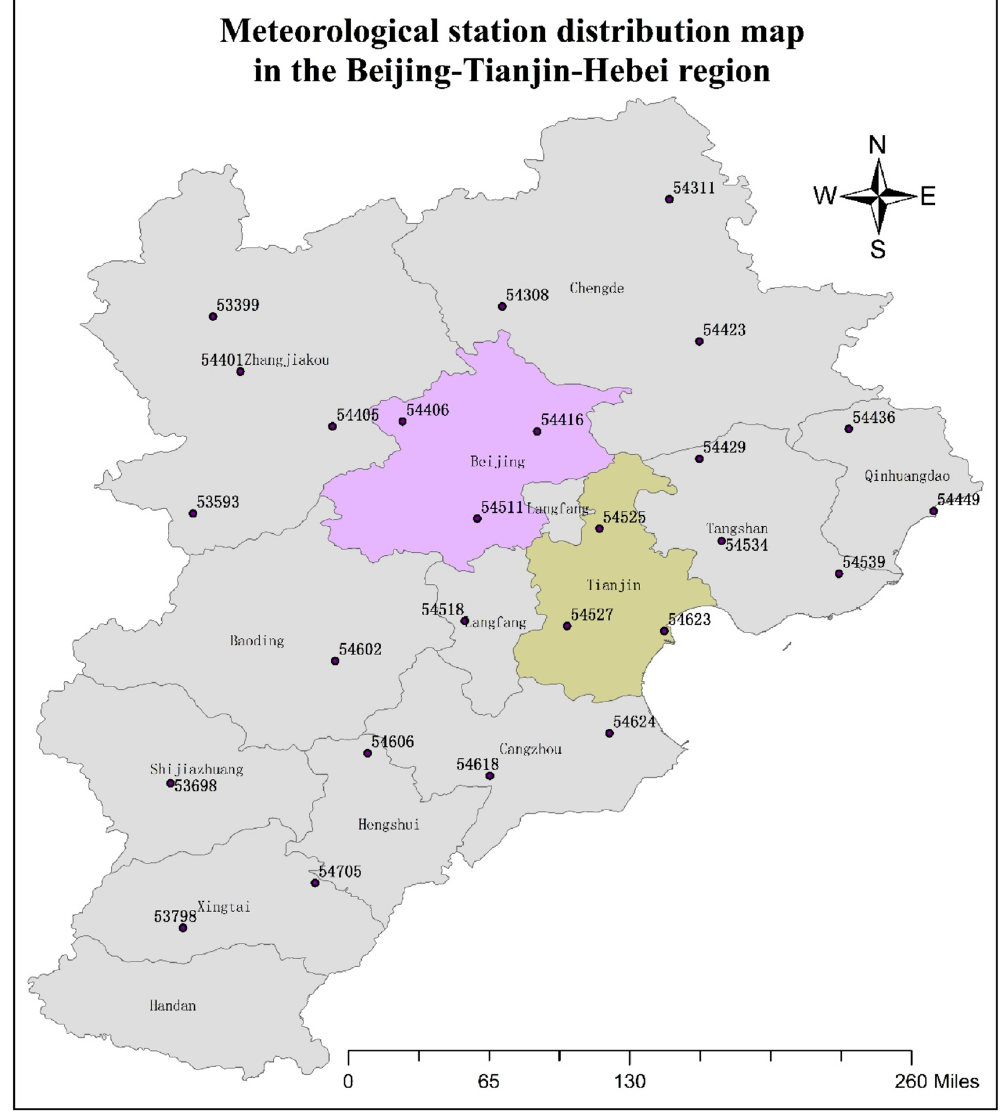
Figure 1. Meteorological station distribution map in the Beijing–Tianjin–Hebei region. The present map was done by using ArcGIS 10.0 desktop version (https ://www.esri.com/zh-cn/arcgi s/produ cts/arcgi s-pro/overv